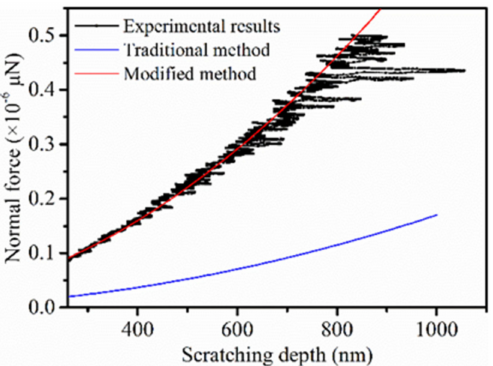
Figure 15. The normal force of comparison of experimental data, traditional prediction, and modified prediction in the brittle scratching